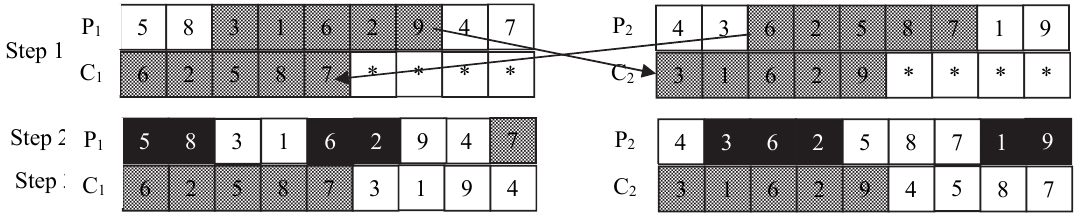
Fig. 5. Crossover